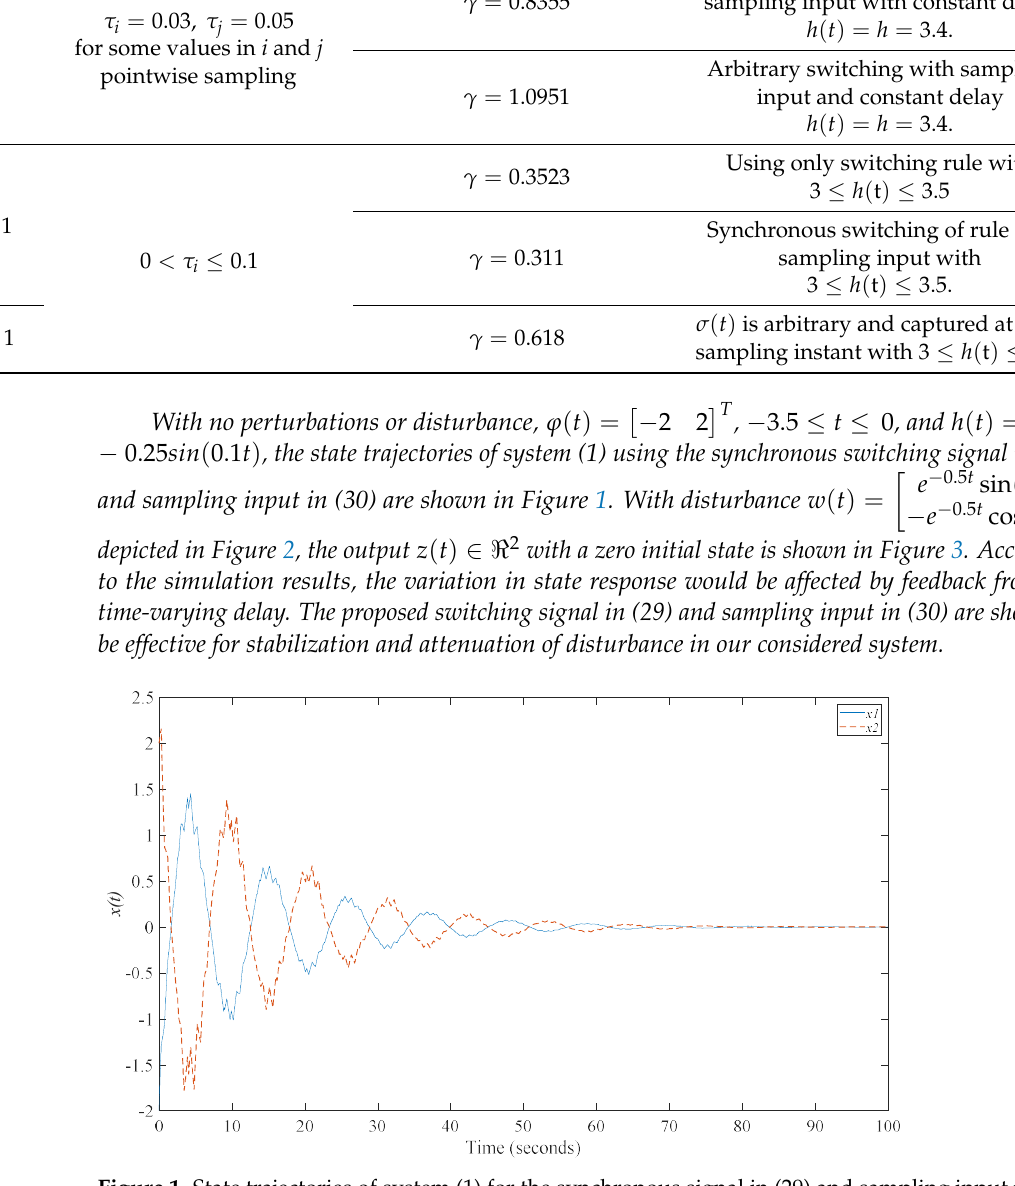
Figure 1. State trajectories of system (1) for the synchronous signal in (29) and sampling input in (30).